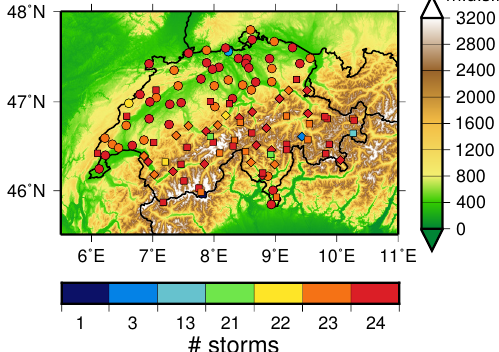
Figure 1. Network of observational sites for wind speed and direc- tion run by MeteoSwiss. The orography of the area is illustrated by the colour shading, whereas each symbol indicates the location of an observational site. The filling colour of the symbols indicates the number of storms (Table 1) entering the analysis that are registered by each station. Symbol shape indicates whether the stations are on a plain (circle), a mountain (square) or in a valley